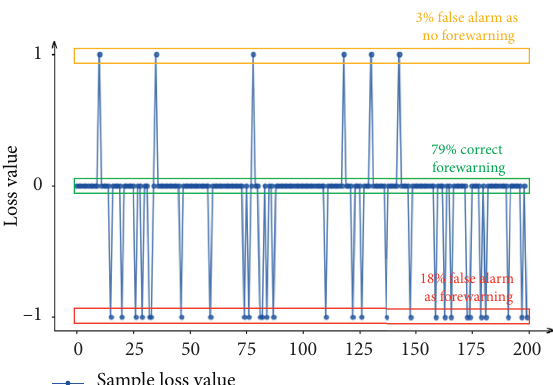
Figure 18: Analysis diagram of sample loss value of fatigue forewarning prediction model.